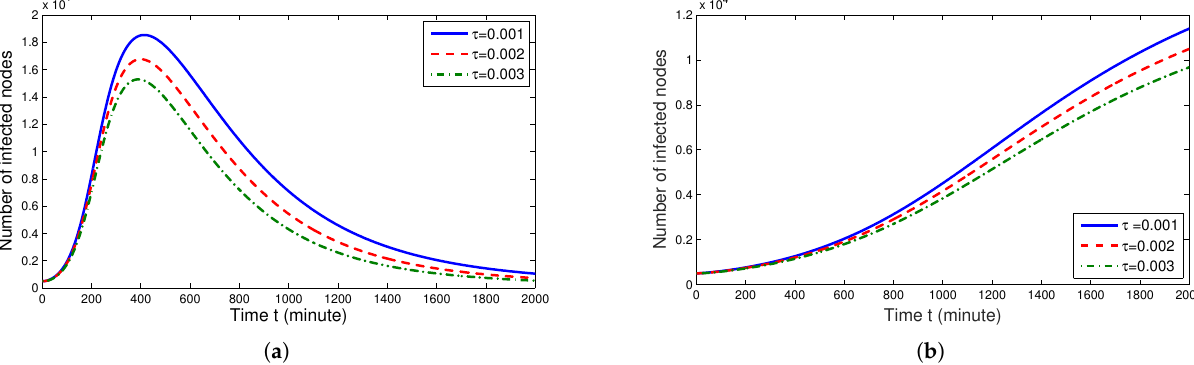
Figure 3. Relation between τ and infected nodes for the fractional order ( a ) θ = 0.95 and ( b ) θ = 0.65,